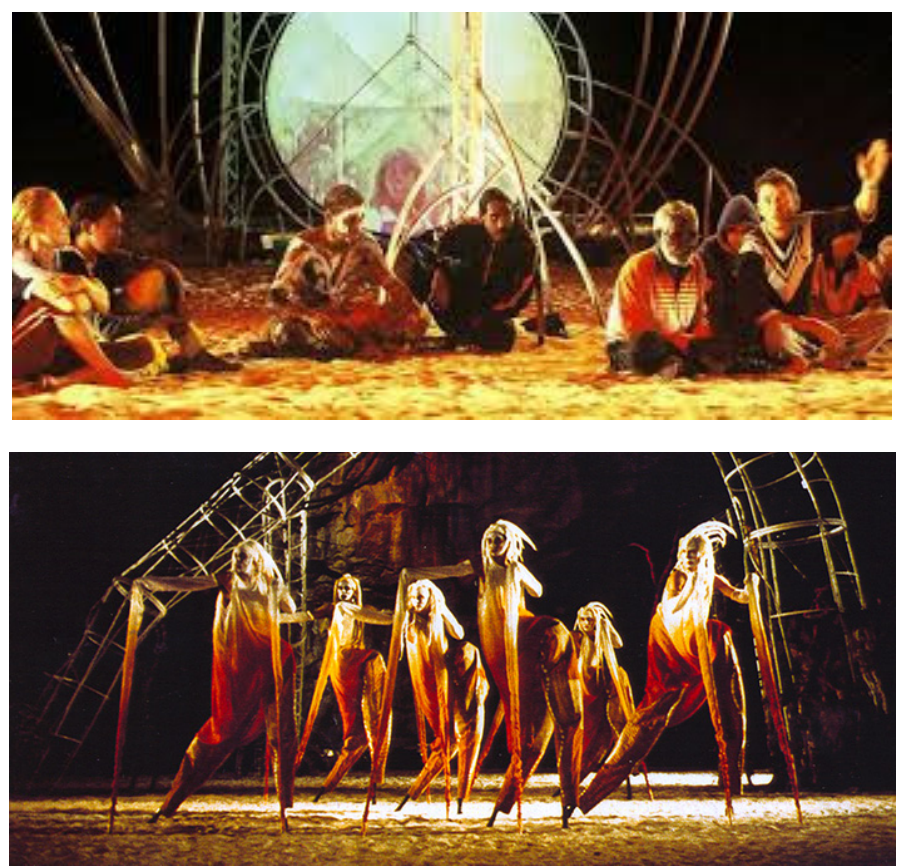
Figure 1. Production stills from Marrugeku production Mimi, Arnhem Land August/September